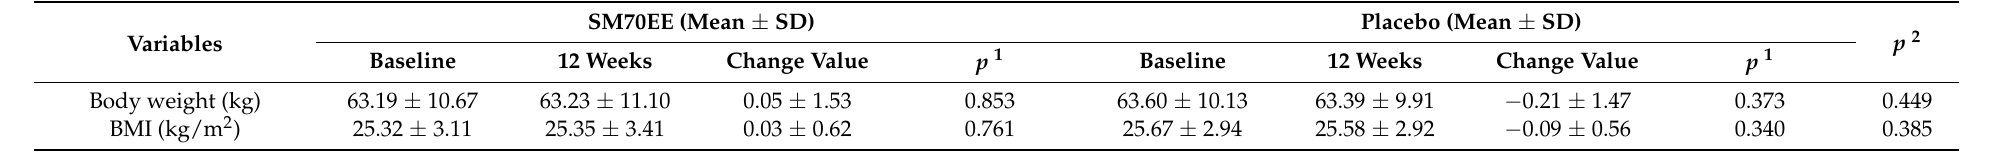
Table 9. Changes in body mass index (BMI) and body weight results before and after 12 weeks of SM70EE product consumption.